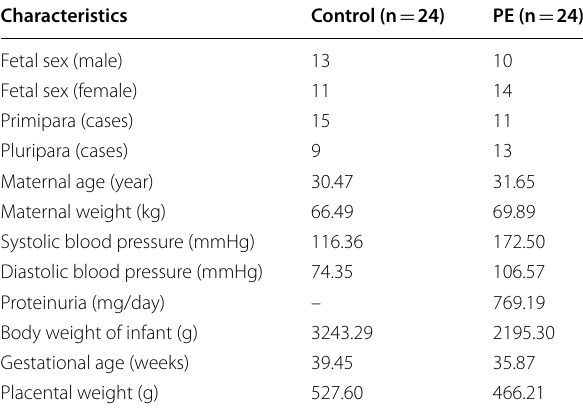
Table 1 Clinical characteristics of normal and